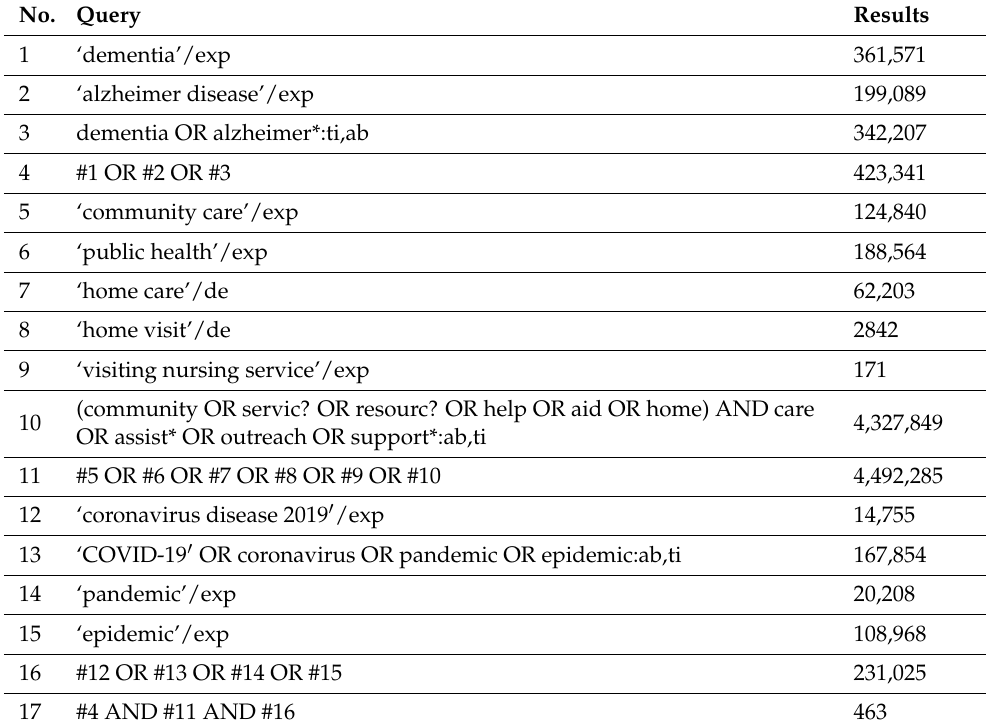
Table A2. Embase (Elsevier). Date of search: 7 July 2020. No.